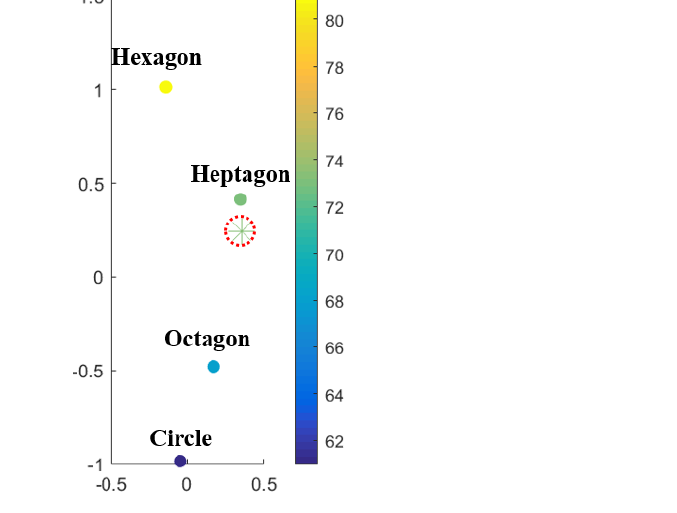
Figure 5. Interpolation space z with color scaling with the values of the effective thermal conductivity K 22